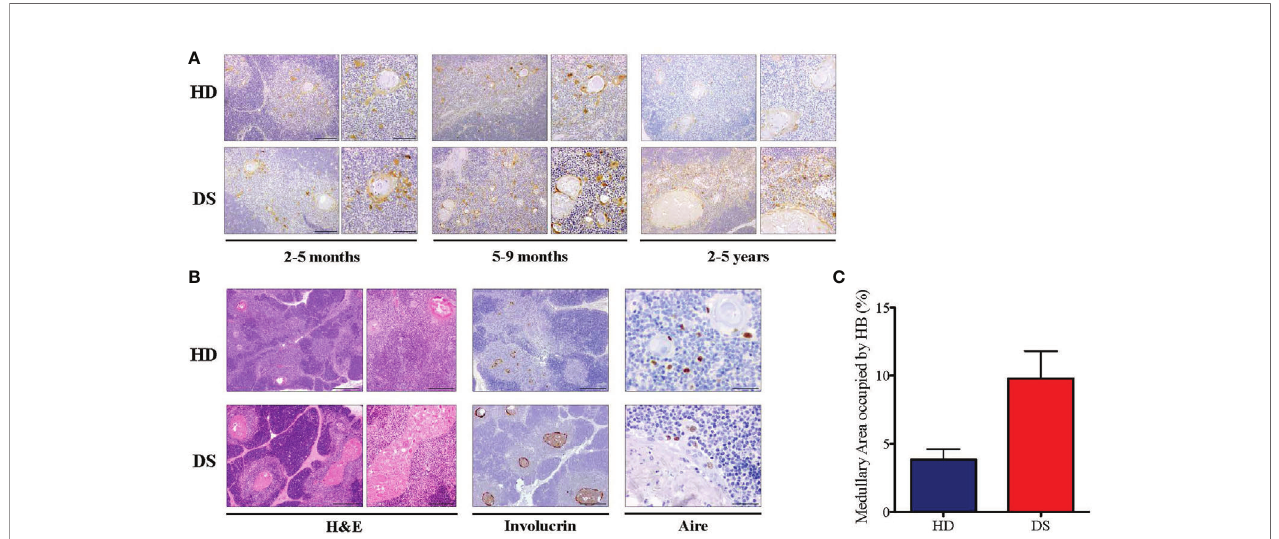
FIGURE 1 | Histological analysis of DS patients thyme. (A) Representative histological images of p16 immunohistochemical staining in three different groups of age- matched HD and DS thymic tissue sections (original magni fi cation: 10x = 200 m m left panel – 20x = 100 m m right panel). For each age group, a minimum of 1-3 thymi were analyzed, according to sample availability. (B) H&E staining and Involucrin and AIRE immunohistochemical staining of HD and DS thymic samples from a 4 year-old DS patient and a 3 year-old healthy donor (original magni fi cation: H&E 4x = 500 m m left panel -10x = 200 m m right panel; Involucrin 4x = 500 m m: AIRE 40x = 50 m m) (HD sample 12 in Supplemental Table 2 ; DS sample 1 in Supplemental Table 3 ) (C) The graph shows the proportion of medullary area occupied by the Hassall ’ s bodies in thymic samples (HD samples: 2, 7 and 12 in Supplemental Table 2 ; DS samples: 1 and 6 in Supplemental Table 3 ). Median with interquartile range is